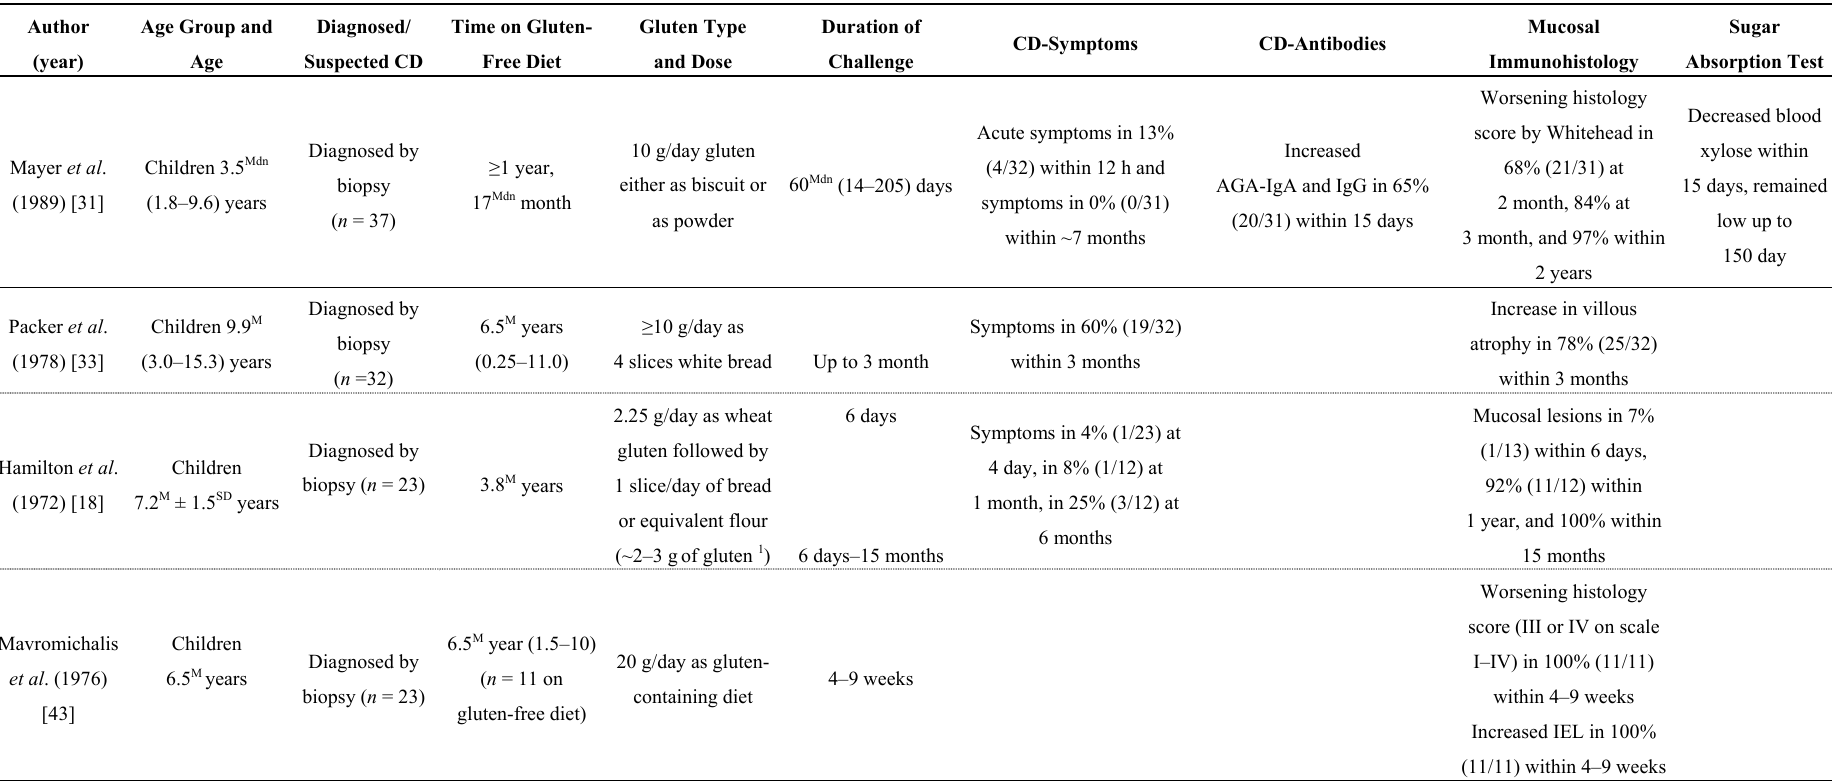
Table 1. The effect of a gluten challenge in pediatric or adult patients on response rate of clinical symptoms, serology, and histology